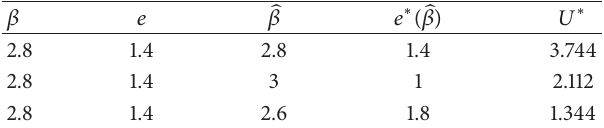
Table 1: Comparison with profit when a different the